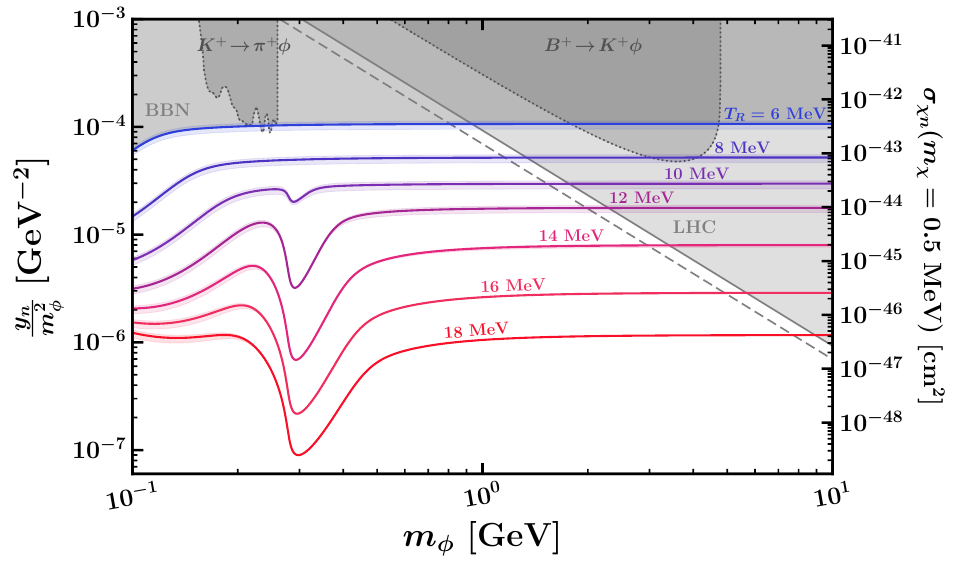
Figure 2 . Predictions for y n /m 2 as a function of m φ along with constraints in gray for y ψ = y χ = 1 . φ The LHC constraint is obtained from eq. (2.8) with m ψ & 1 . 5 ( 2 ) TeV for shaded region (long dashed line) for current (possible future) constraint. The colored contours yield the correct relic abundance for m χ = 0 . 5 MeV for various reheating temperatures. The right vertical axis is the scattering cross section for m χ = 0 . 5